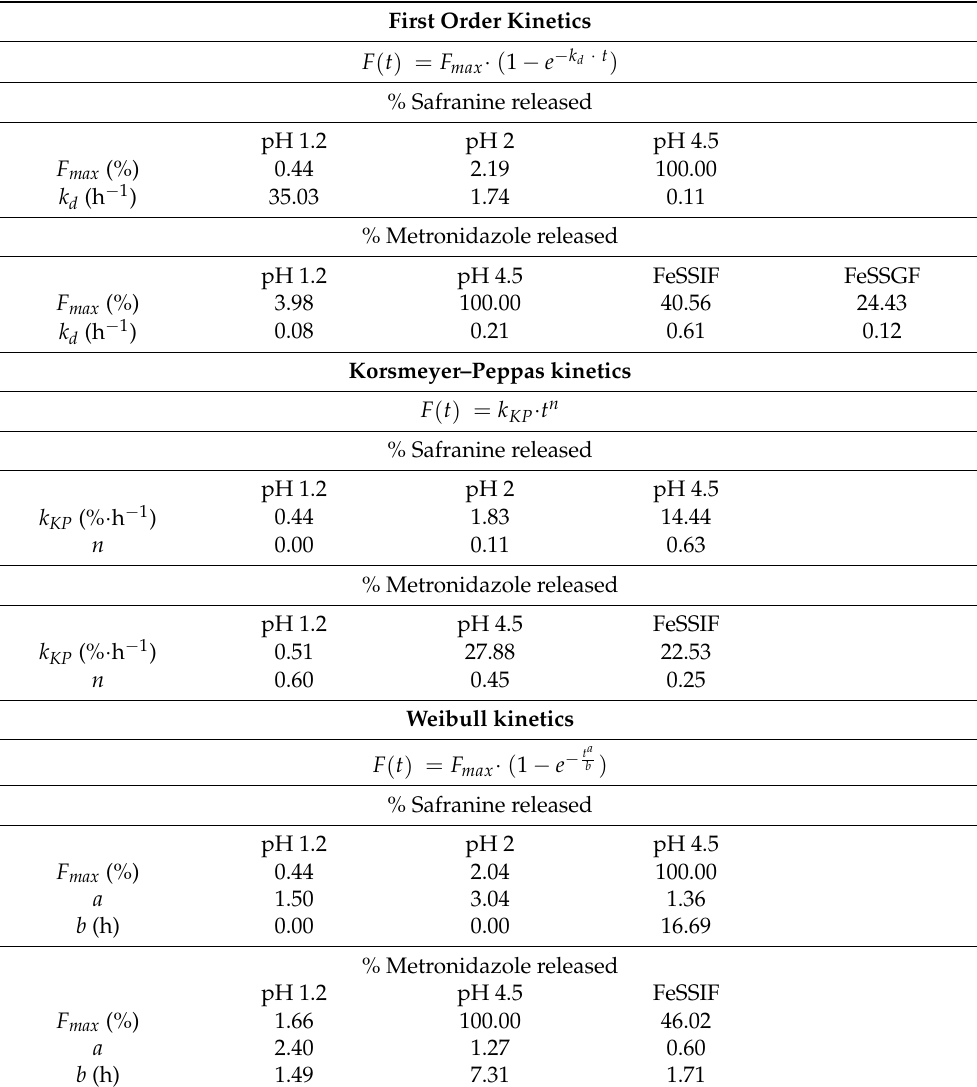
Table 3. Summary results of parameters obtained with three kinetics model